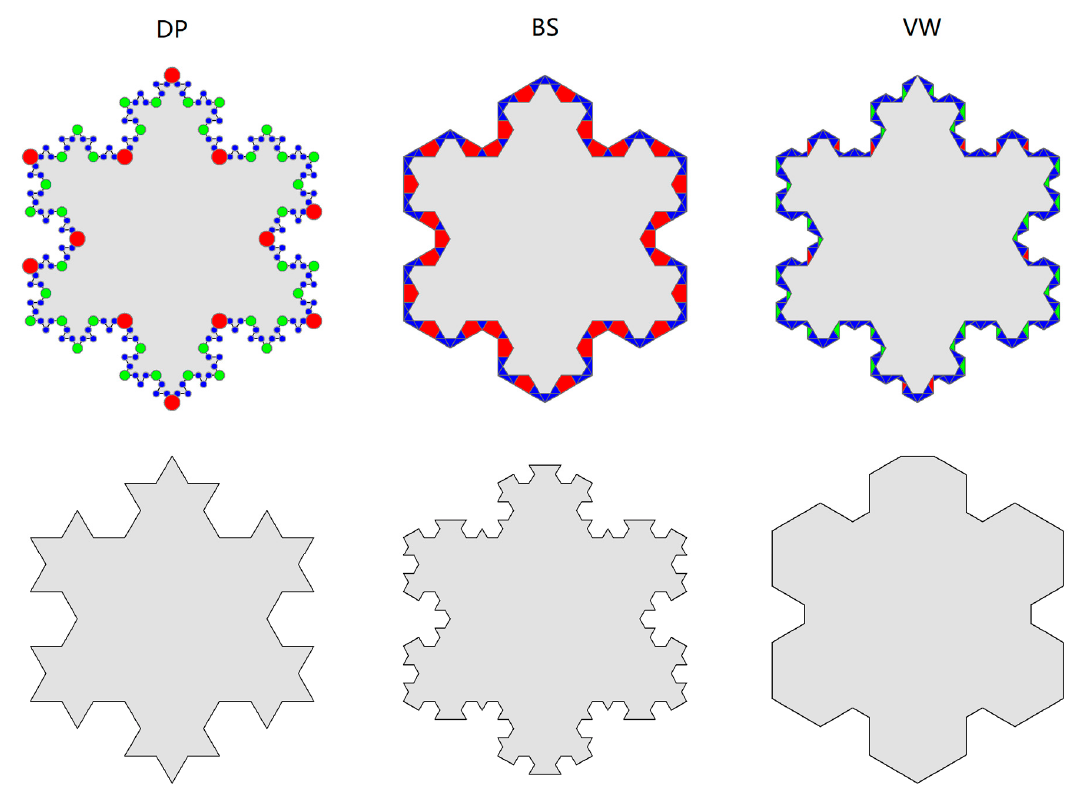
Figure A1. (Color online) The illustration of simplifying geometric units among DP, BS, and VW algorithms using Koch snowflake and the generalization result at the first level. (Note: The size of each type of simplifying units, such as points, triangles, and bends, holds the underlying scaling hierarchy that includes a great many smalls (in blue), a few larges (in red), and some in between (in green), all of which can be used for the guidance of cartographical generalization).